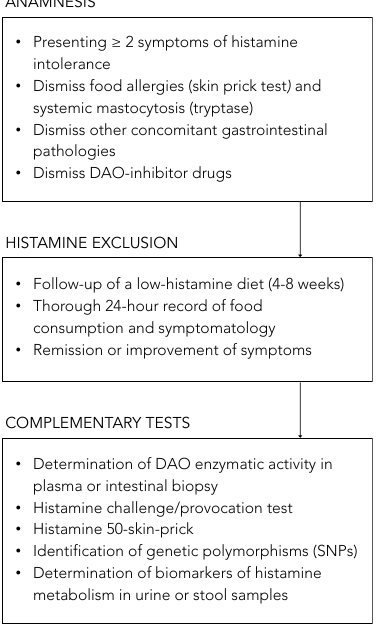
Figure 7. Summary of the described approaches to the diagnosis of histamine intolerance. SNPs: single-nucleotide